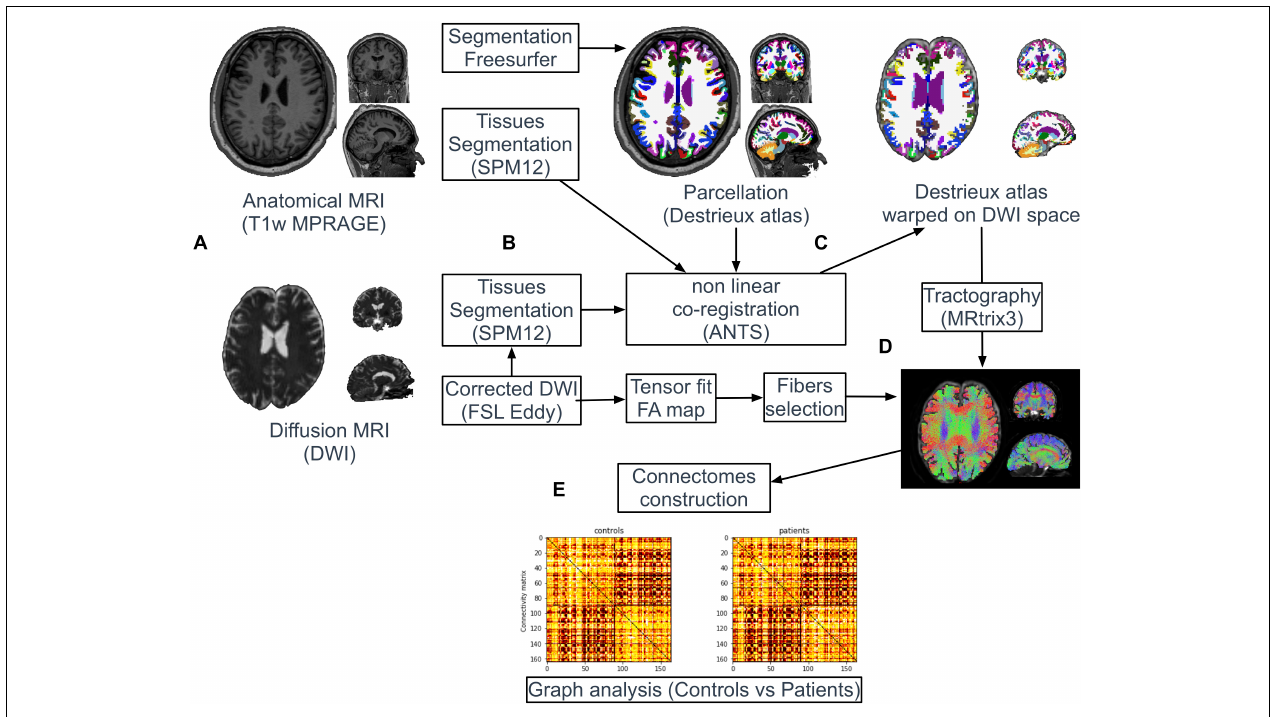
FIGURE 1 | Pipeline of image processing and graph analysis. T1w and diffusion MRI sequences were acquired from all patients and controls (A) . Following automatic parcellation of the structural images into cortical and subcortical regions (B) , the two set of images were non-linearly co-registered (C) . White matter tracts were reconstructed based on diffusion data using the probabilistic algorithm of MRtrix (D) . Individual brain network maps were generated using nodes and white matter connections resulting in a FA-weighted connectivity matrix for each subject. Graph analyses were performed on the FA-based connectivity matrix (E)